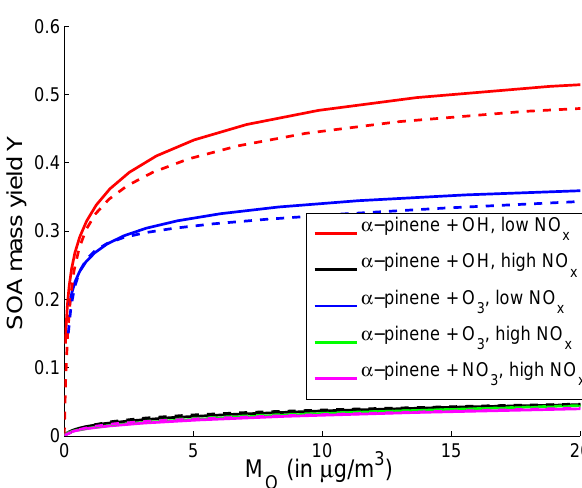
Fig. 6. Net SOA mass yields near SOA equilibrium in the full model (solid lines) and parameter model (dashed lines) at 298K for the five α -pinene oxidation scenarios, as functions of organic aerosol mass loading.